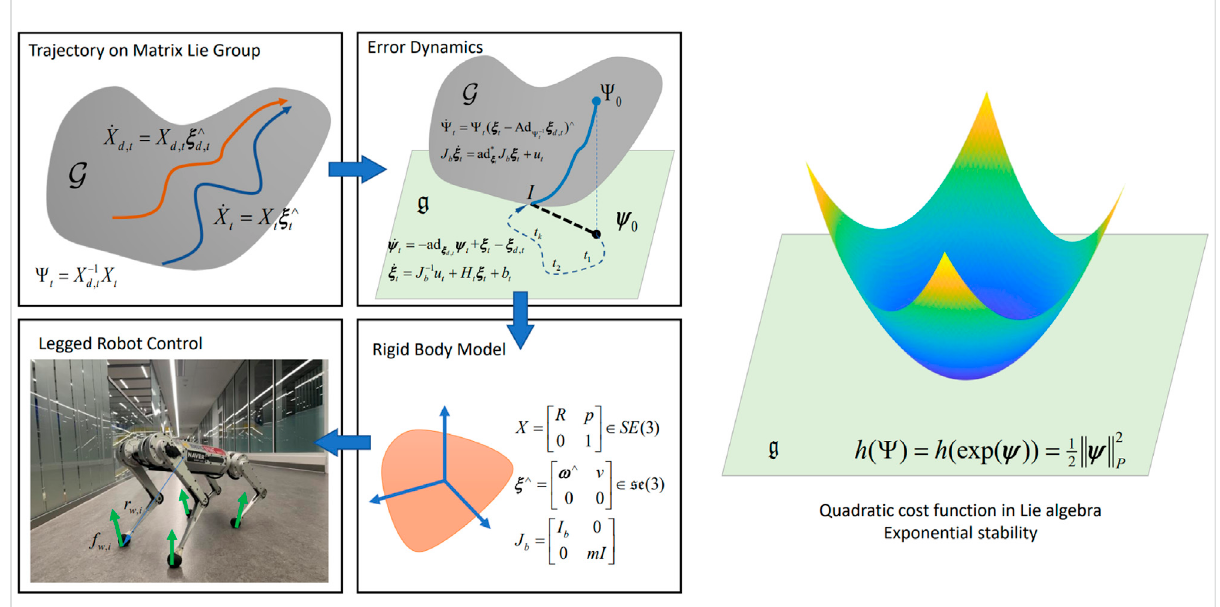
FIGURE 8 The proposed error-state MPC framework by Teng et al. (2022a). The tracking error is de fi ned on a matrix Lie group and linearized in the Lie algebra. A convex MPC algorithm is derived via the linearized dynamics for tracking control. The proposed algorithm is applied to a single rigid body system and veri fi ed on a quadrupedal robot MIT Mini Cheetah. A quadratic cost function in the Lie algebra can verify the stability of the proposed